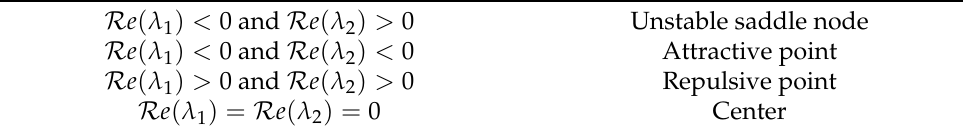
Table A1. Classification of the fixed points according to the type of